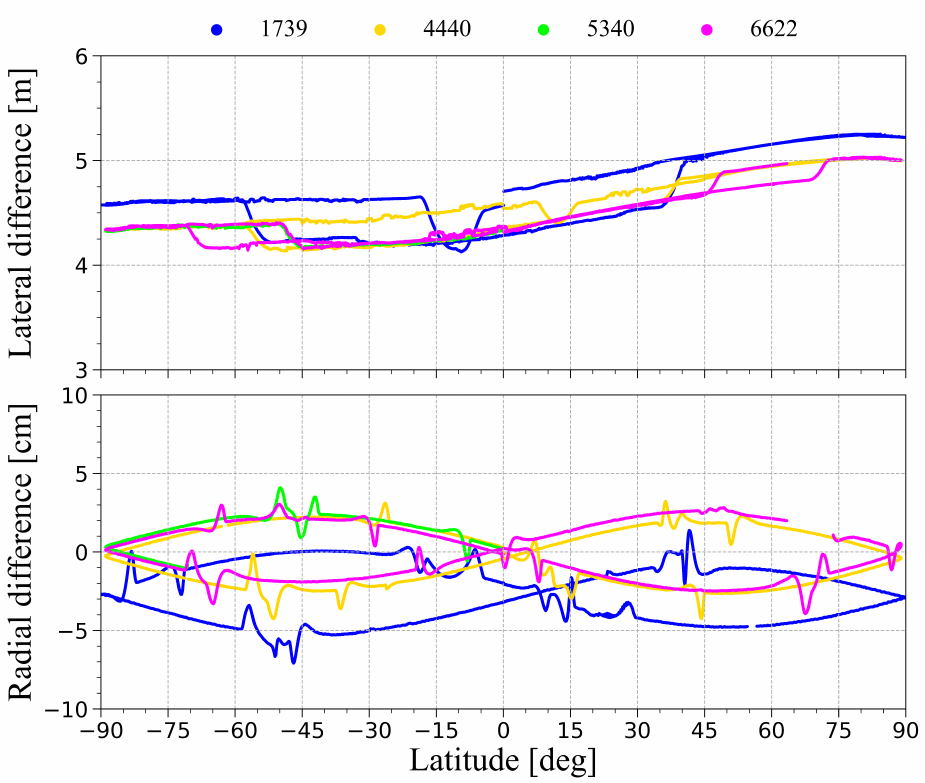
Figure 4. Lateral ( top ) and radial ( bottom ) differences of PAM with Mars as the observer with respect to SMM with Mars as the observer (impact of pointing aberration) for the selected off-nadir